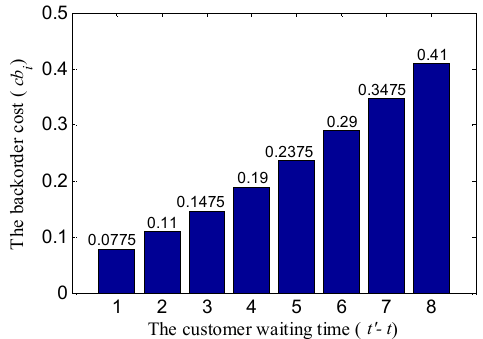
Figure 12. The rate of backorder cost. The experiments are performed on DELL Vostro 3800-R1846 (Intel Core i3 4130 (3.4 GHz 8 GB memory)) 10 times. The results of performance measures are reported in Table 8 and Figure 13, respectively. Table 8. The results of performance